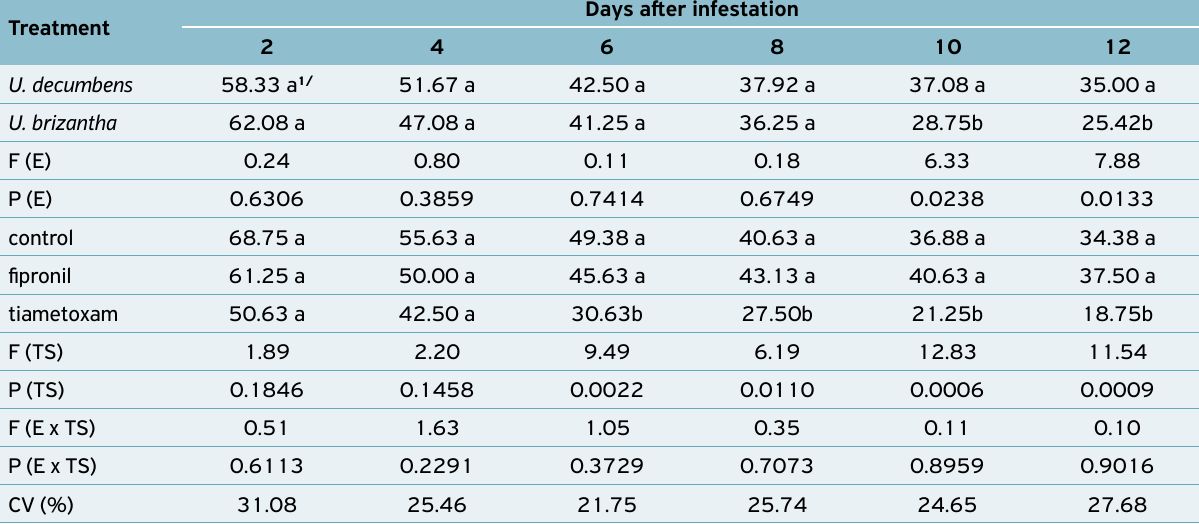
Table 1. Percentage of survivals of D . flavopicta in cages on U . decumbens and U . brizantha , submitted to seed treatment with insecticides. São José do Rio Preto SP Brazil,